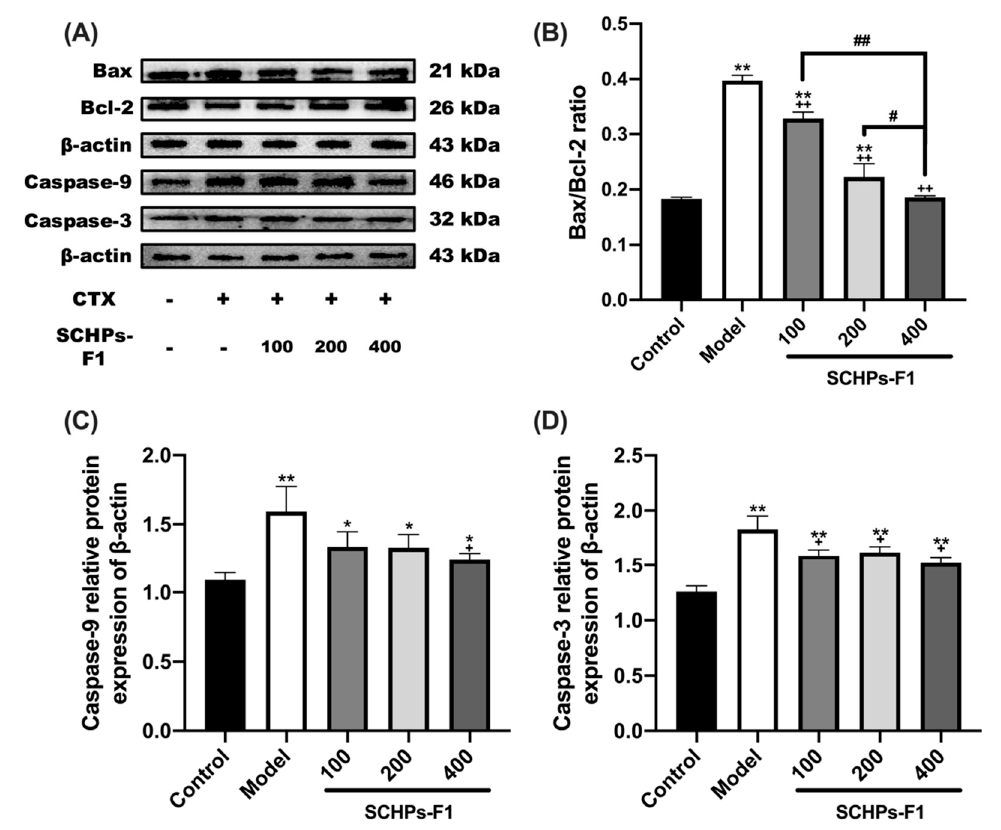
Figure 5. Effects of SCHPs-F1 treatment on CTX-induced changes in Bax/Bcl-2 ( A , B ) ratio, caspase-3 ( A , C ) and caspase-9 ( A , D ) expression in kidney tissue. * p < 0.05, ** p < 0.01, vs. control group; ( A , C ) and caspase-9 ( A , D ) expression in kidney tissue. * P < 0.05, ** P < 0.01, vs. control group; + P < + p < 0.05, ++ p < 0.01, vs. model group; # p < 0.05, ## p < 0.01 indicate significant di ff erences between 0.05, ++ P < 0.01, vs. model group; # P < 0.05, ## P < 0.01 indicate significant differences between di ff erent SCHPs-F1 dose different SCHPs-F1 dose groups.